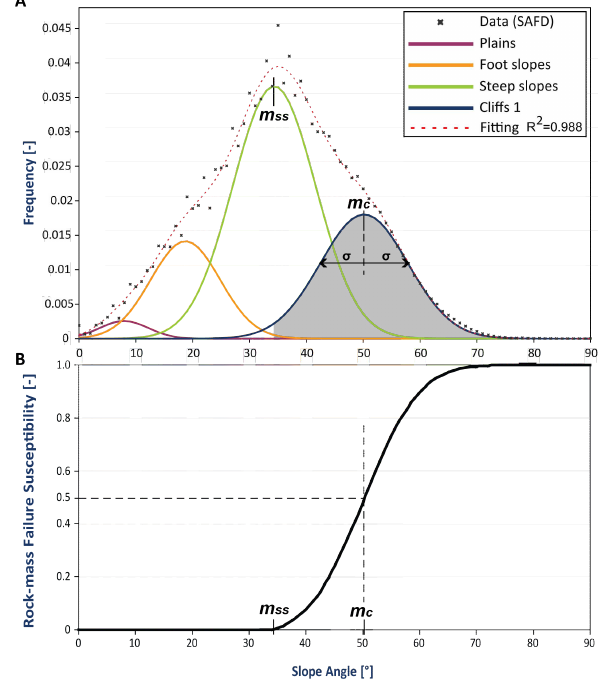
Fig. 2. (A) Normal distributions of the slope angles of the granitoids HMA in the Bagnes Valley, extracted from a 10m-DEM. Three pa- rameters are used to detect potential rockfall source areas: m c which is the mean angle of the cliffs distribution and σ its standard devi- ation; m ss which is the mean angle of the steep slopes distribution. In this case, cliffs units are decomposed in only one normal distri- bution. (B) Normalized cumulative distribution function ( F n ) for the cliffs units, assimilated to a quantitative weighting of potential rockfall source areas, i.e. to a rock-mass-failure susceptibility. The mean angle of the steep slopes distribution m ss is used as a first threshold to exclude lower values as potential rockfall source